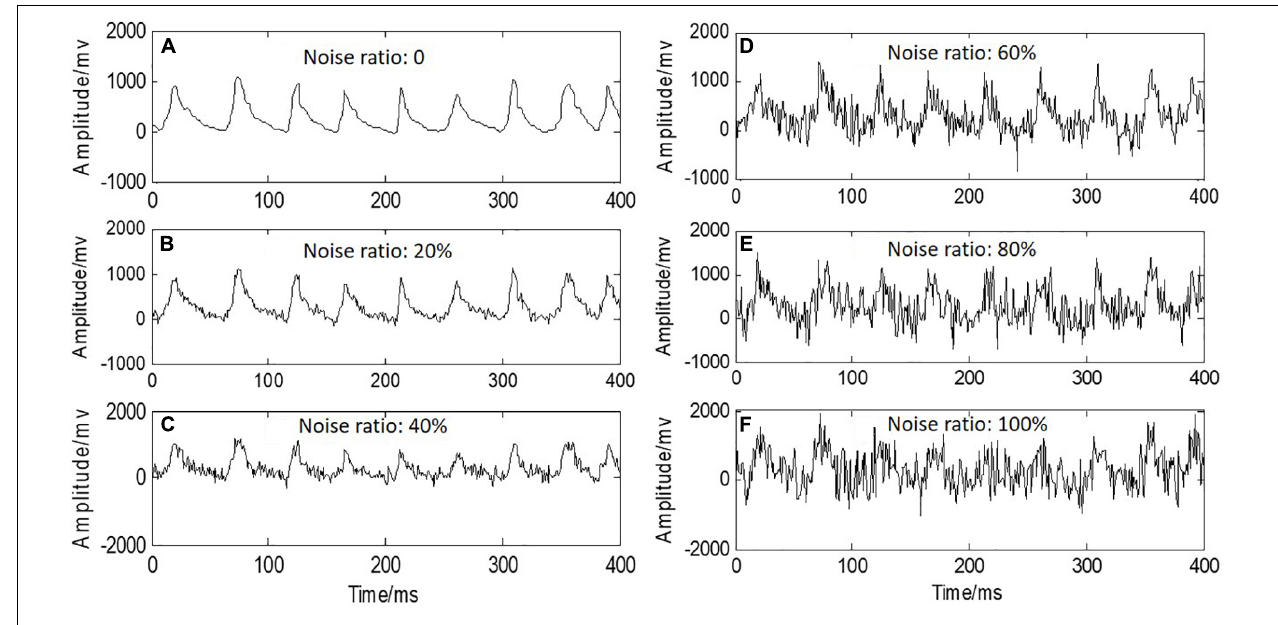
FIGURE 9 | An example of RSC signals added with whiten Gaussian noise with noise ratio from 0 to